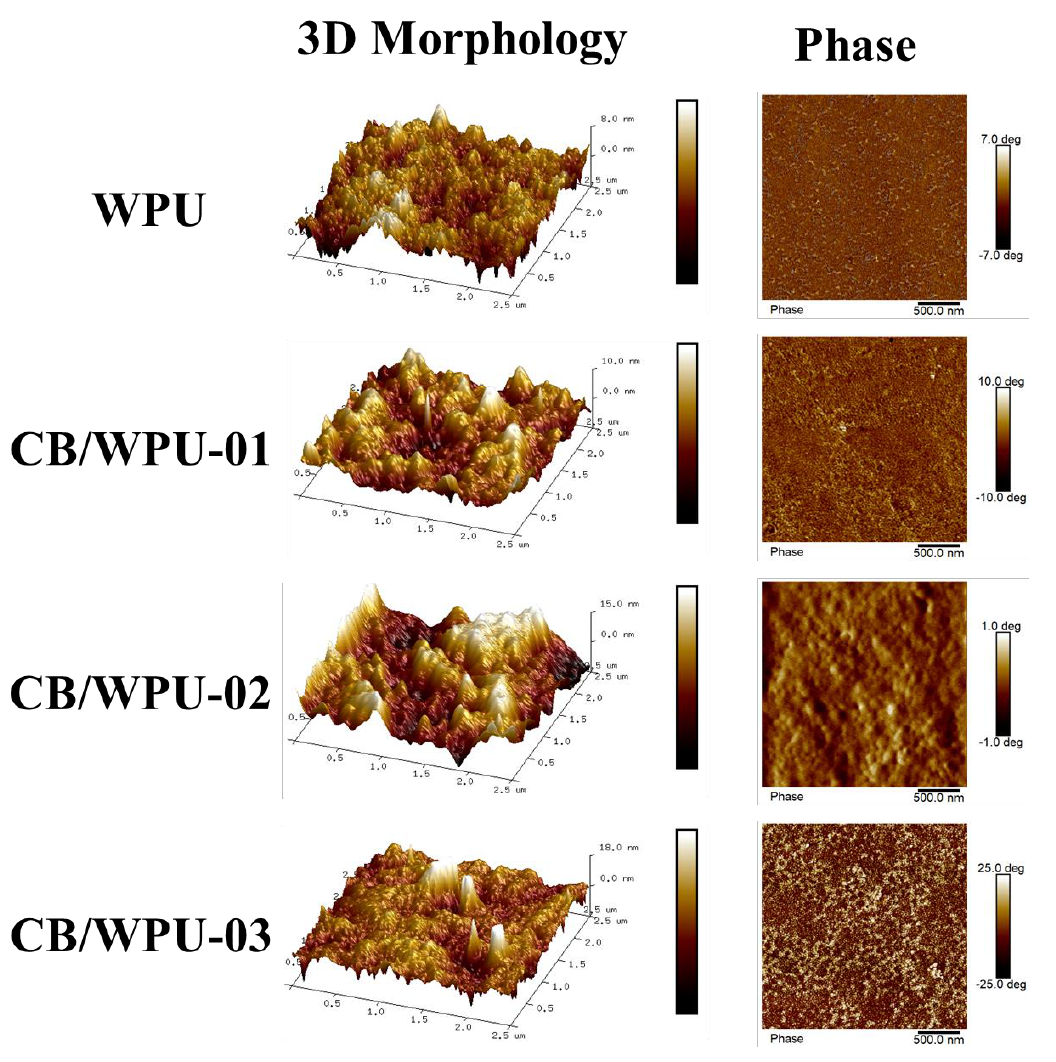
Figure 3. AFM 3D Morphology and phase images of the CB/WPUs.